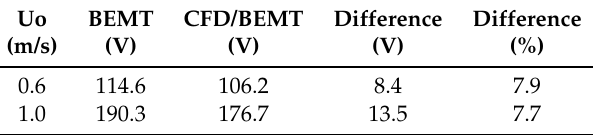
Figure 13. Generator phase voltage at Uo = 1.0 m/s. for ( a ) 15 s and ( b ) between 10.0 s and 10.5 s. Table 9. Generator phase voltage (RMS).